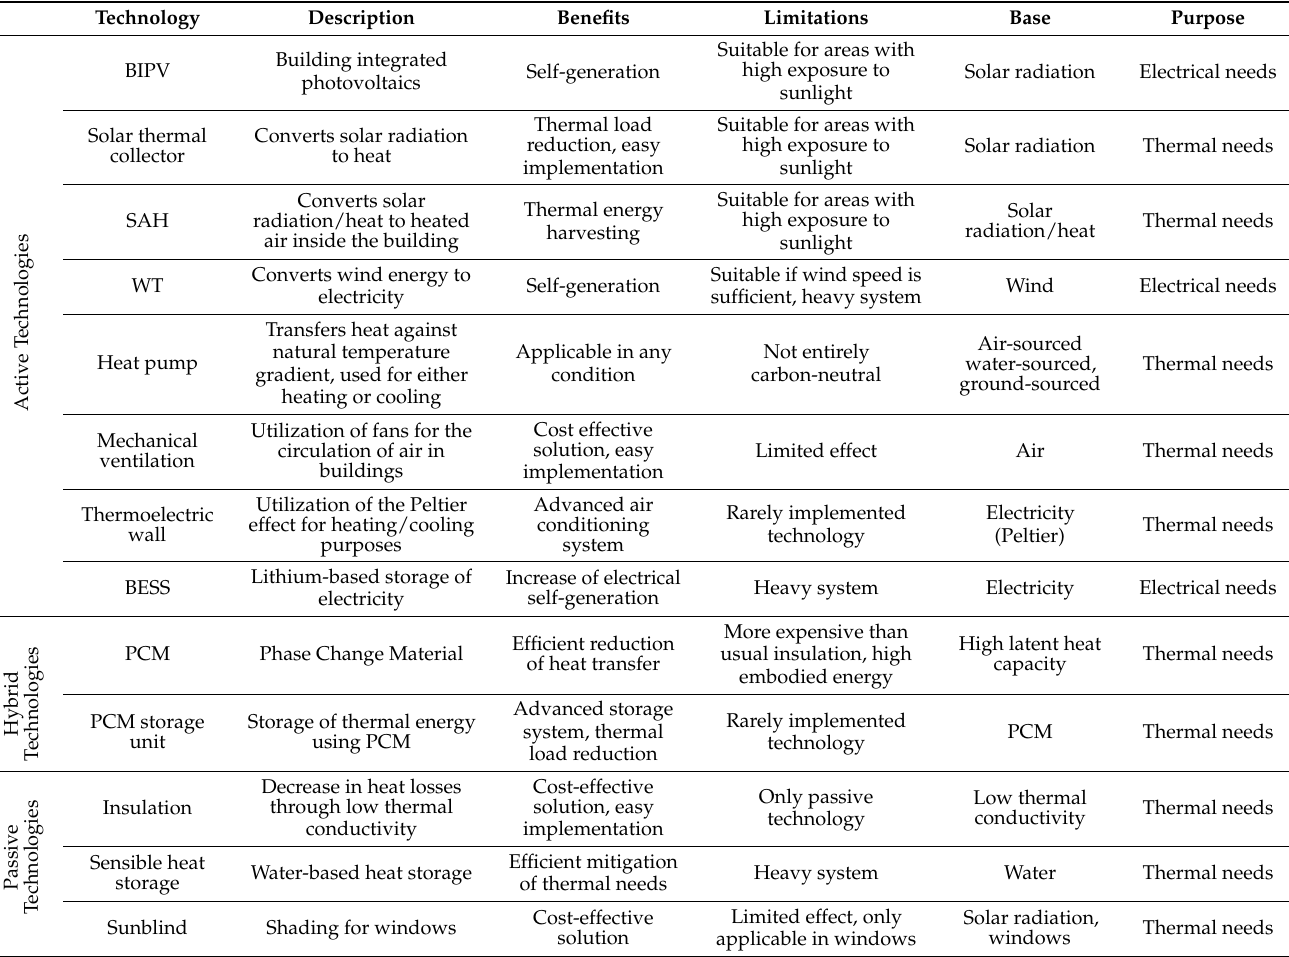
Table 1. Main technologies for ADBEs